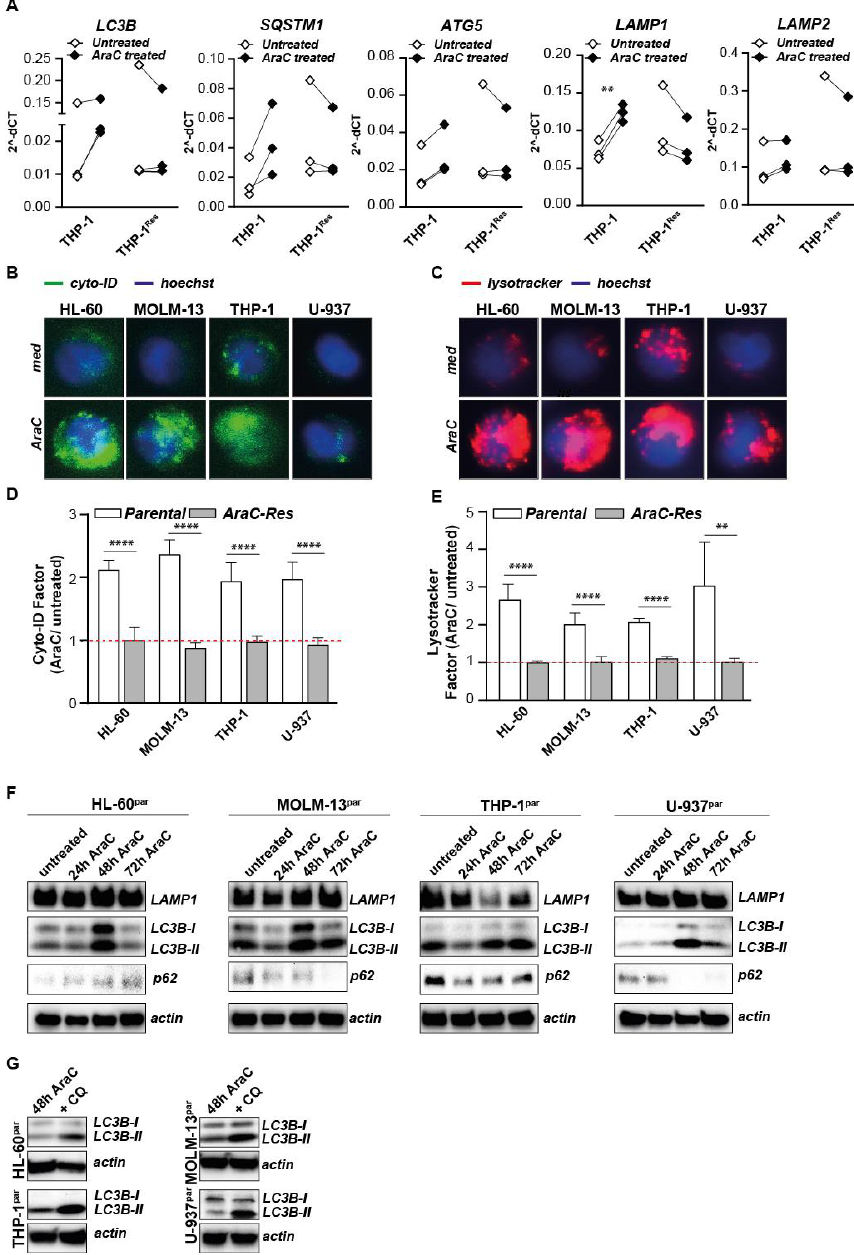
Figure 3. The autophagy pathway is activated upon AraC treatment in parental but not AraC resistant cells. ( A ) mRNA levels of LC3B , SQSTM1 , ATG5 , LAMP1 , and LAMP2 upon AraC treatment (24 h, 4000 nM AraC) in parental THP-1 and THP-1 AraC-Res cells ( n = 3). ( B , C ) Representative fluorescent microscopy pictures showing the autophagosomal and lysosomal content in parental cell lines in untreated versus AraC treated cells, captured at 40 × magnification. ( D , E ) As in ( B , C ) but quantified using flow cytometry Factor change in cyto-ID ( D ) and lysotracker ( E ) signal upon AraC treatment as determined by flow cytometry ( n = 6 for parental cell lines and n = 3 for AraC-Res cell lines). ( F ) Representative Western blots showing the activity of the autophagy pathway during AraC treatment (24, 48, and 72 h) based on LC3B-II formation ( n = 2). ( G ) Representative Western blots showing the activity of the autophagy pathway during AraC treatment (24, 48, and 72 h) based on p62 degradation ( n = 2). In all experiments, a sub-lethal dose of AraC was used that reduced the cell viability with ~20%, i.e., 250 nM for HL-60 and MOLM-13, 100 nM for U-937 and 4000 nM for THP-1. Significance was tested using student’s t -test. p values are indicated as: **** p < 0.0001, ** p <